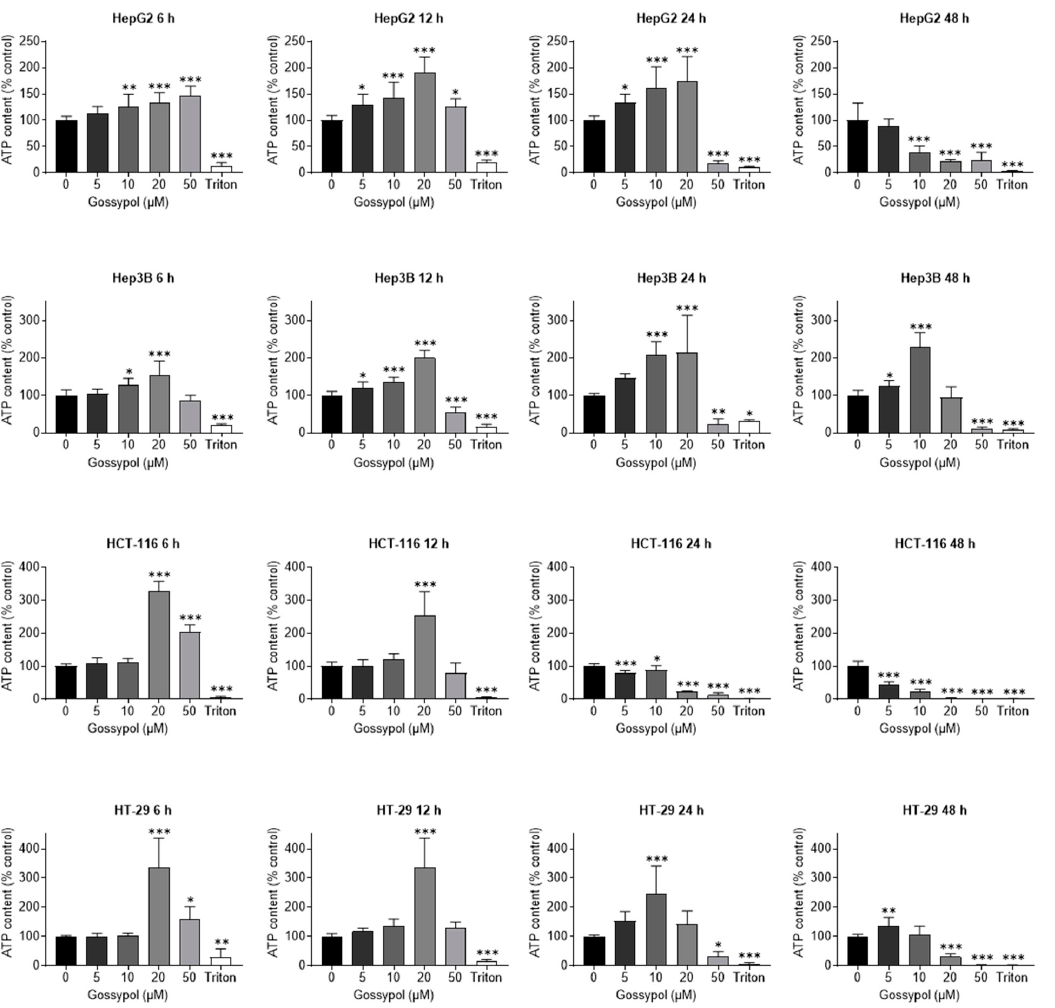
Figure 4. Gossypol alters cellular ATP levels. Photometric determination of the relative ATP content after gossypol incubation (6 h, 12 h, 24 h, 48 h) in a concentration-dependent manner (5 µ M, 10 µ M, 20 µ M, 50 µ M) for both cancer types (hepatoma: HepG2, Hep3B; colon carcinoma: HCT-116, HT-29). Medium alone (negative control) and 0.1% ( v / v ) Triton X-100 (positive control) were used for all cell lines. Error bars represent mean ± SD of three independent experiments, each performed in triplicate. For statistical analysis, one-way ANOVA with Dunnett’s multiple comparison test was applied. Confidence interval 95%; * p ≤ 0.05; ** p ≤ 0.01; *** p ≤